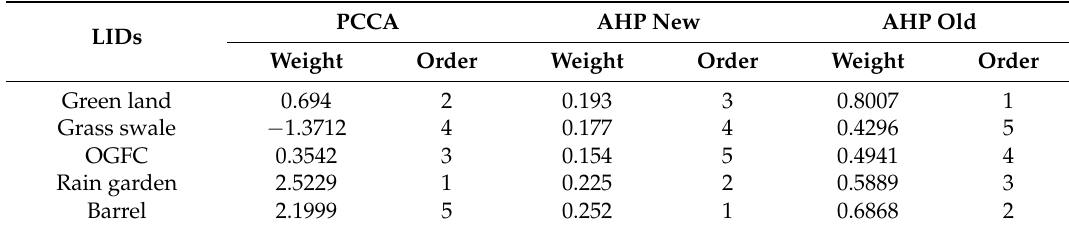
Table 16. The LID efficiency rank for different methods.